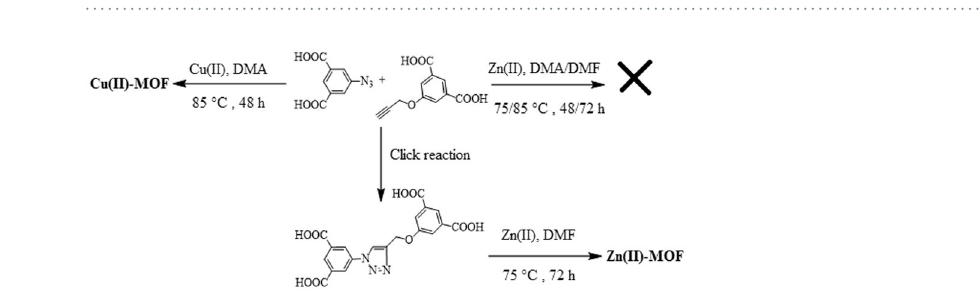
Figure 3. HR-TEM images of the CuMOP-N1(Cu) polymer ( A ) and ( B ) showing the regular distribution of spherical cages within the extended coordination network, and ( C ) the ligand oriented stepwise construction of metal-organic extended network based on MOPs using their edges (ligands) via click reaction and further metal coordination.